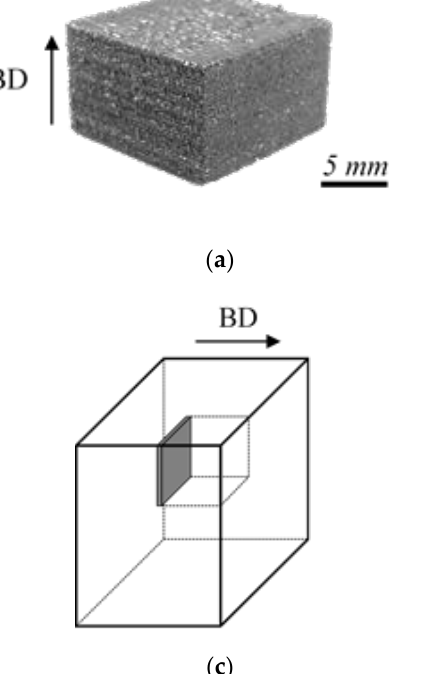
Figure 2. SEBM specimens investigated in the present work, where the arrows indicate the build direction (BD) of the SEBM blocks: ( a ) Specimen A; and ( b ) Specimen B. ( c , d ) Schematic illustration of locations where samples for microstructural characterization were taken out: ( c ) sample taken out from Specimen A; and ( d ) sample taken out from Specimen B.